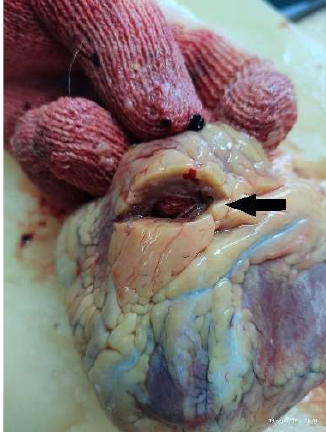
Figure 2. EAT thickness for LAD incision.